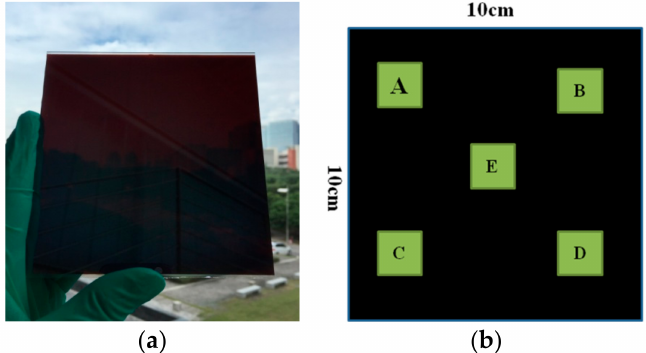
Figure 2. MAPbI 3 thin film (100 cm 2 ) ( a ), and the detected A, B, C, D and E regions in the large MAPbI 3 thin film ( b